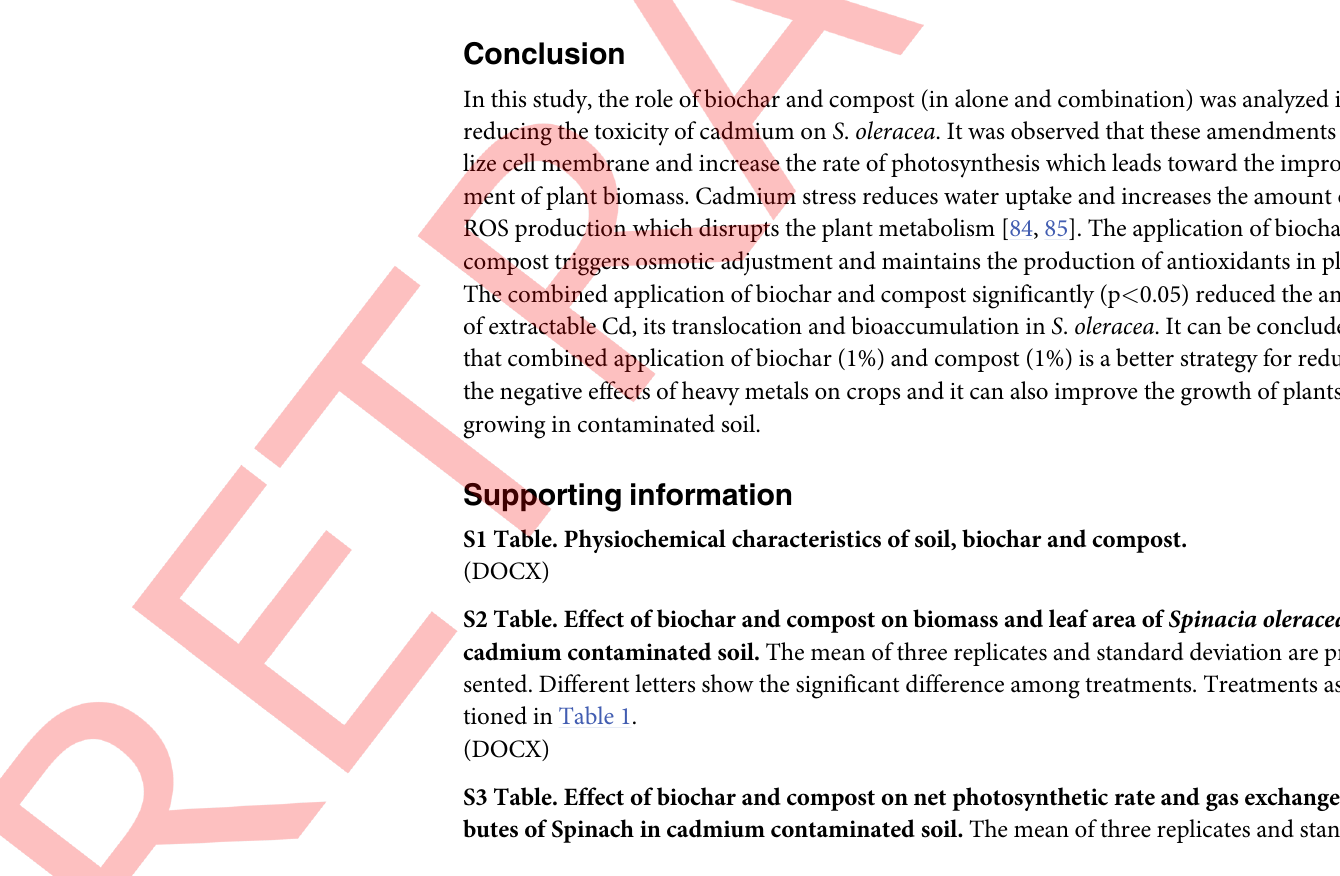
S1 Table. Physiochemical characteristics of soil, biochar and compost. S2 Table. Effect of biochar and compost on biomass and leaf area of Spinacia oleracea in cadmium contaminated soil. The mean of three replicates and standard deviation are pre- sented. Different letters show the significant difference among treatments. Treatments as men- tioned in Table 1. S3 Table. Effect of biochar and compost on net photosynthetic rate and gas exchange attri- butes of Spinach in cadmium contaminated soil. The mean of three replicates and